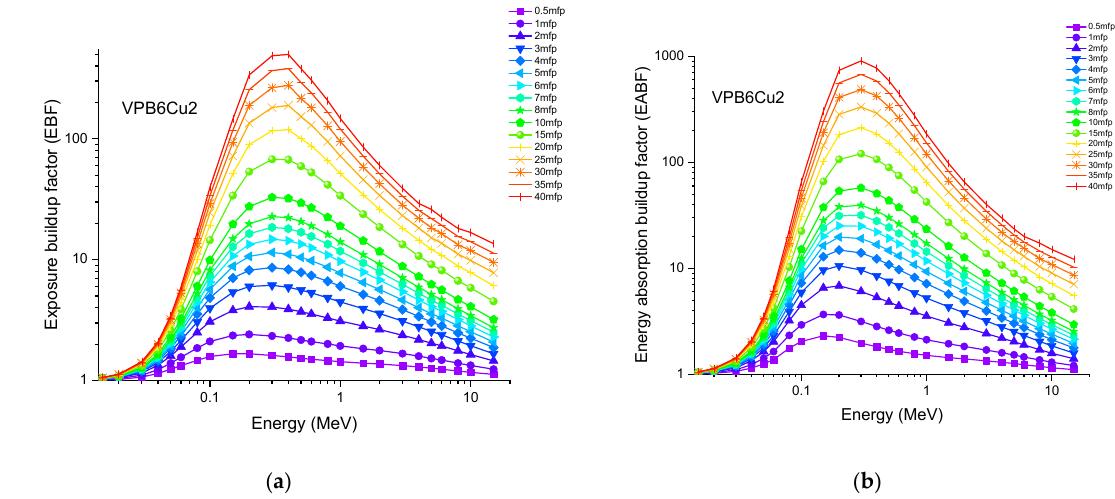
Figure 12. Variation of ( a ) EBF and ( b ) EABF against photon energy for sample VPB6Cu2.